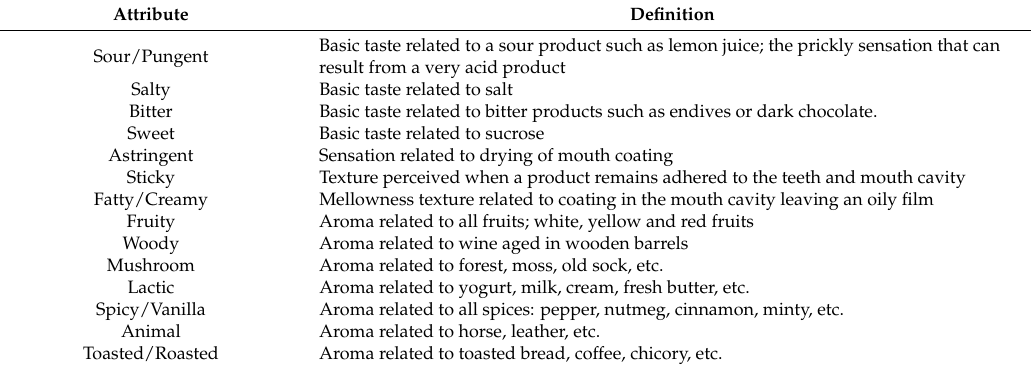
Table 3. Definitions used to explain the attributes presented for the description of wines, cheeses and their